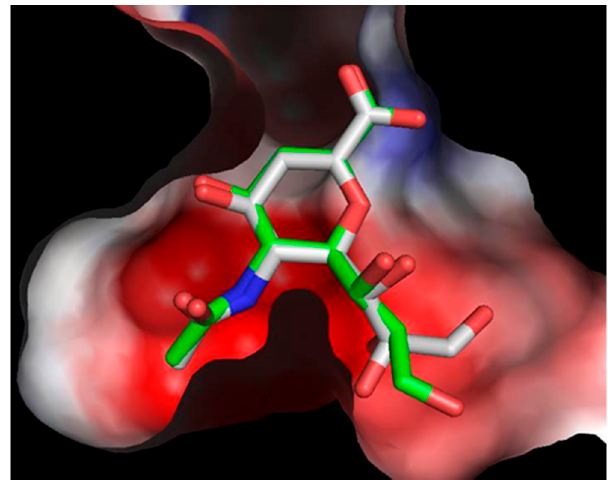
Figure 4. Best scored binding mode for DANA obtained with AutoDock Vina (gray) and binding mode for DANA in the original crystal structure (green). The TcTS surface is color-coded by the electrostatic potential (blue shift showing positive electrostatic potential & red shift showing negative electrostatic potential).